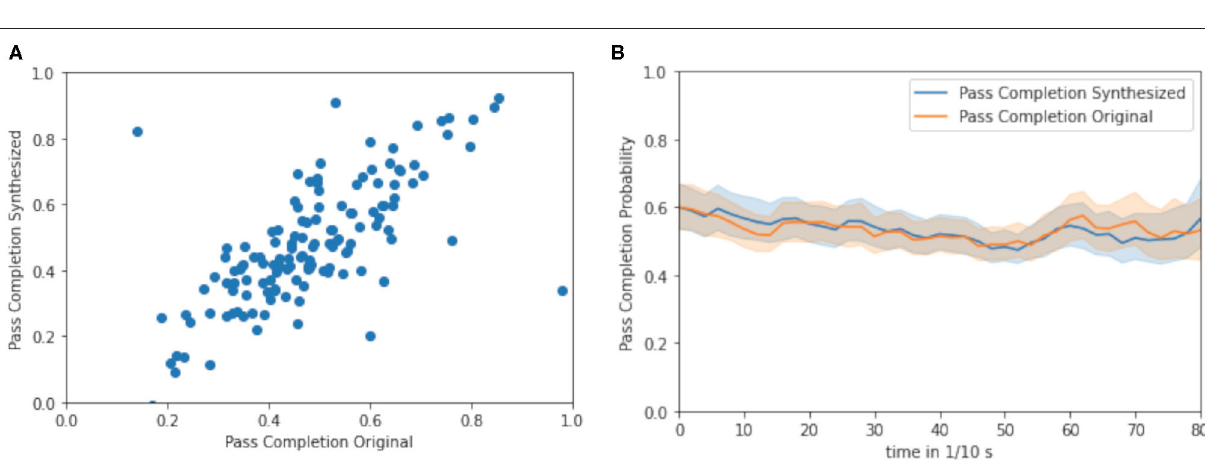
network approach was chosen due to the higher AUROC